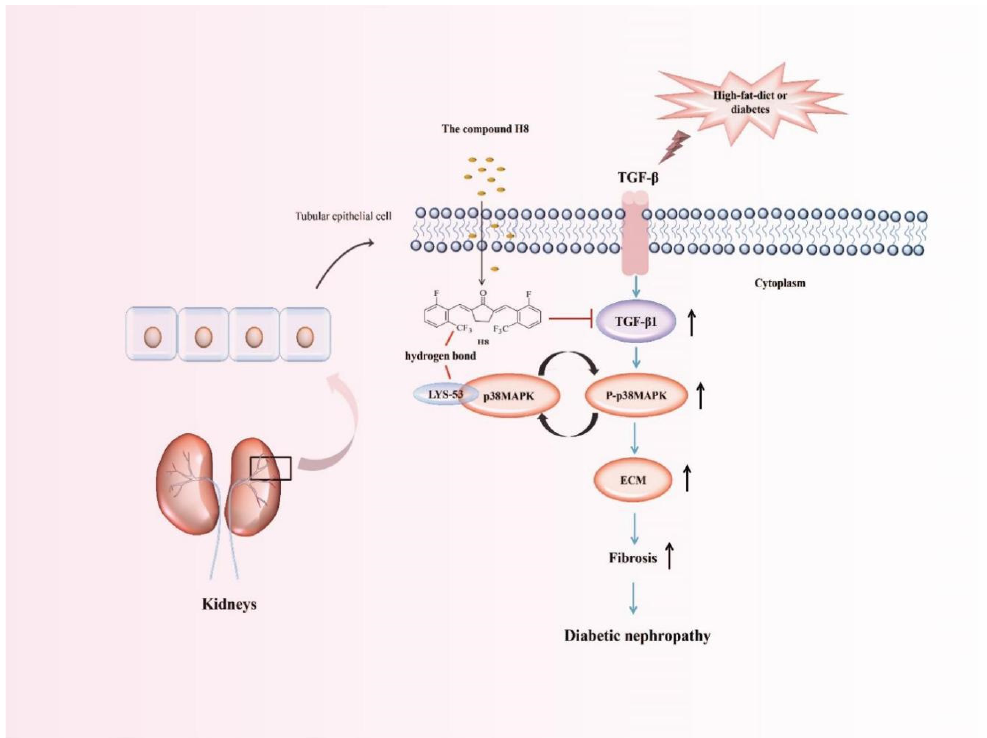
Figure 9. The cyclopentanone compound H8 improved DN via suppressing TGF- β /p38MAPK axis in vitro and in vivo.